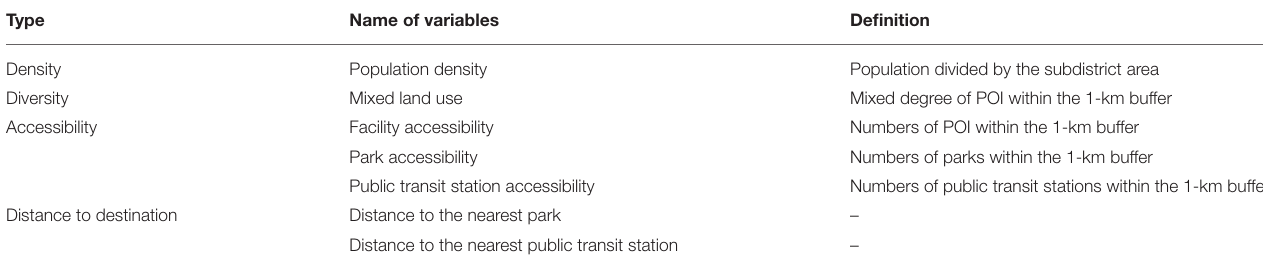
TABLE 2 | Built environment of the